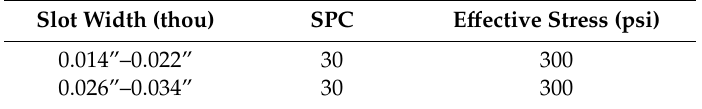
Table 1. Testing matrix to study the role of slot width at constant slot density.